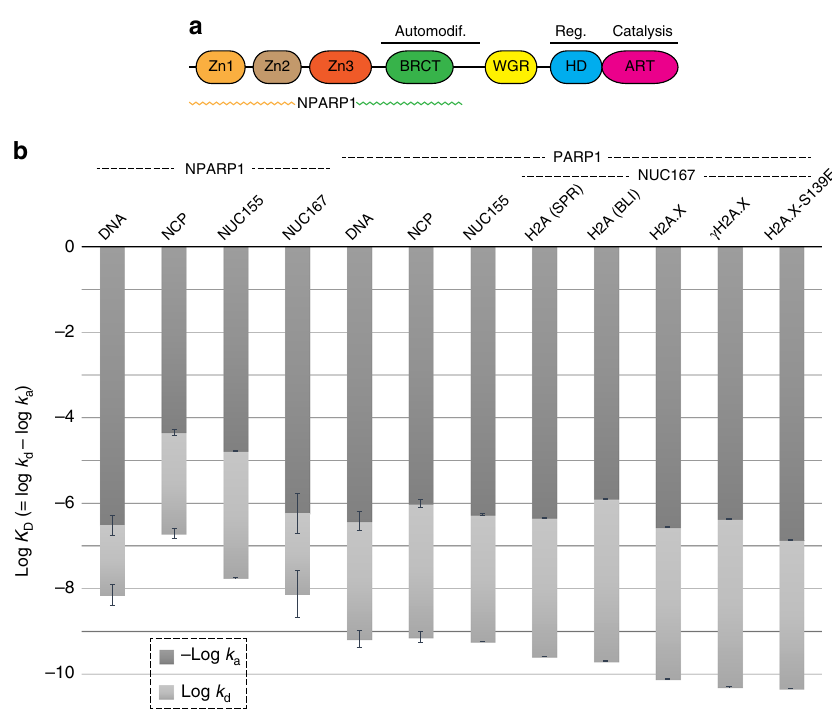
Fig. 1 PARP1 association with DSB activators. a Domain structure of the 1024 amino acid PARP1 and corresponding N-terminal half truncation construct (NPARP1). b Kinetic parameters for NPARP1 and PARP1 binding to naked DNA, NCP and nucleosomal substrates measured by SPR (eight samples, left; mean ± s.d., n = 2 independent experiments) and BLI (four samples, right; mean ± s.d., n = 3, 2, 3, 2 independent experiments). Source data are provided as a Source Data fi